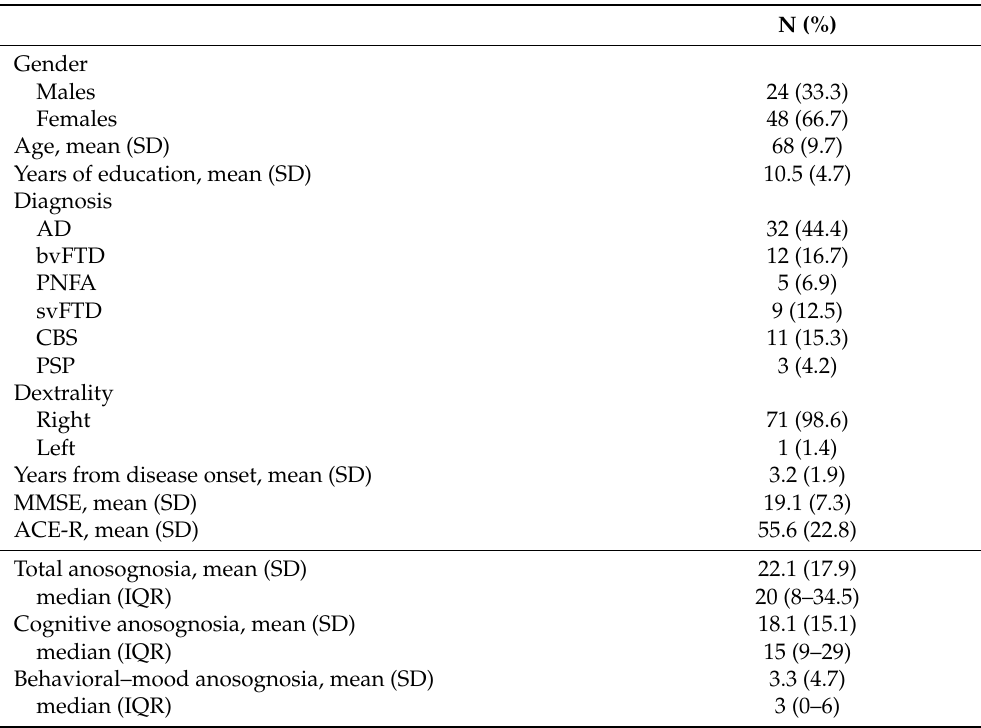
Table 1. Sample characteristics.